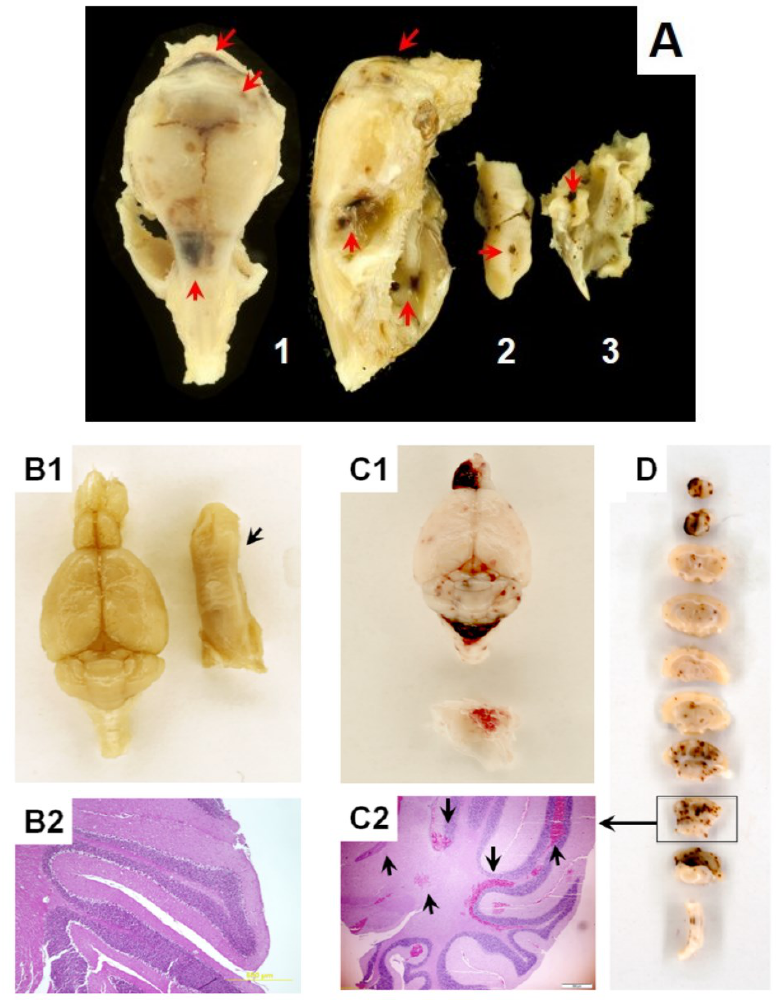
Figure 2. Development of hemorrhagic vasculopathy in irradiated B6D2F1/J mice at the mortality period. Gross pathology and histopathology assessment (hematoxylin and eosin staining, i.e. , H & E) of intracranial hemorrhage in moribund B6D2F1/J mice subjected to hARS. Panel A . (1) Images a mouse skull: dorsal plane (left) and lateral plan (right); (2) Image of tongue; (3) Image of a fragment of skull shown in (1). Brownish areas of extravasated blood are indicated with red arrows. Panels B1 and B2 are specimens from a sham animal. Tongue is indicated with a black arrow in B1 . Panels C1 , C2 , and D are specimens from an irradiated animal. A fragment of cranium is indicated with a black arrow in C1 where the presence of epidural hemorrhage is observable. Panels B2 and C2 display H & E-staining images of coronal sections through the cerebellar cortex. Panel D displays gross-image of coronal sections through entire brain. As shown in C1 and D subdural and interstitial hemorrhage randomly occurred in different part of the brain; predominantly affecting cerebellum and olfactory. Experimental conditions: as indicated in the Figure